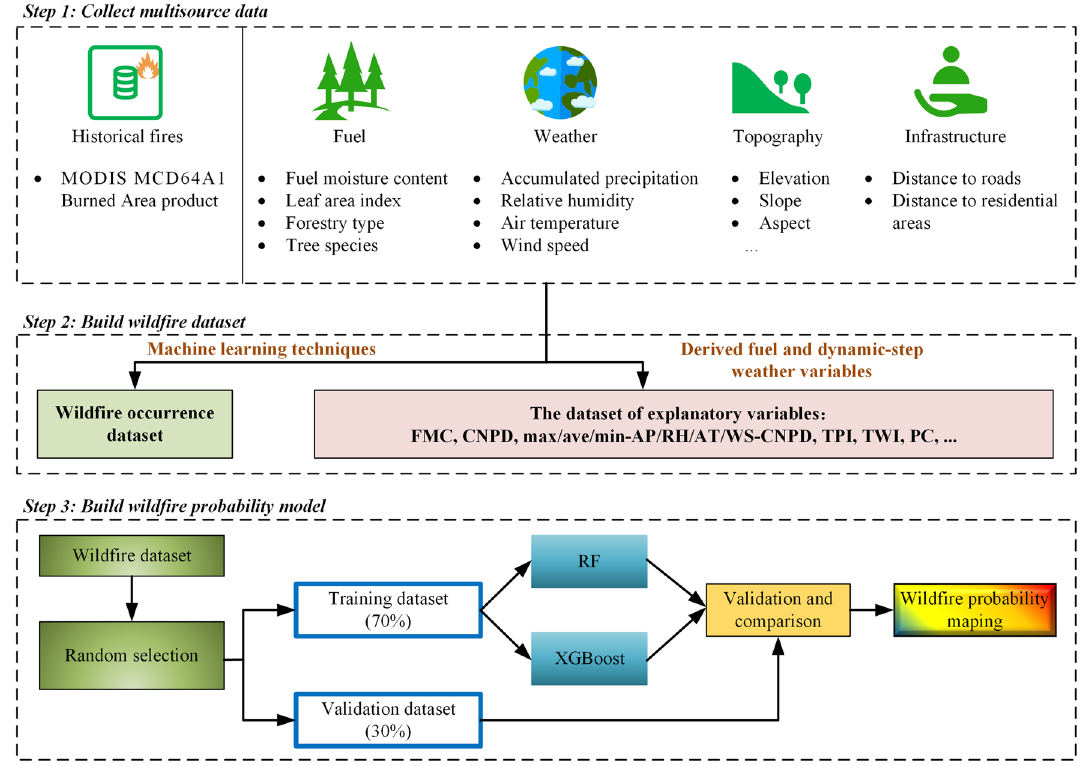
Fig. 2 Workflow of the methodology adopted in this study. AP accu- mulated precipitation; AT air temperature; CNPD continuous nonpre- cipitation days; FMC fuel moisture content; PC plan curvature; RF